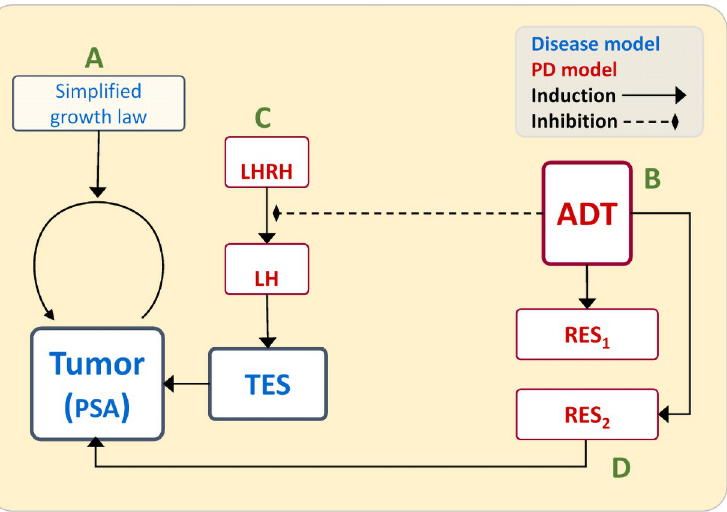
Fig 1. Schematic representation of the model of the ADT therapy for HSPC